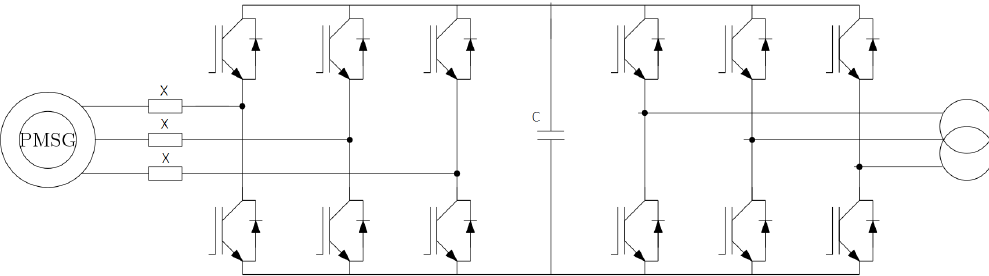
Figure 22. Permanent magnet synchronous generator including generator-side and grid-side power